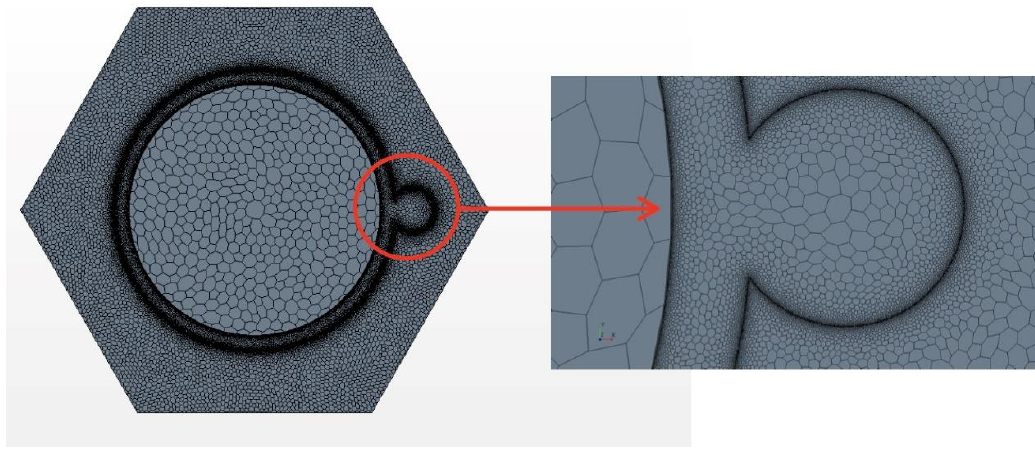
Figure 14. The mesh of solid model and local detail view profile . Table 6. Details of solid model grids.